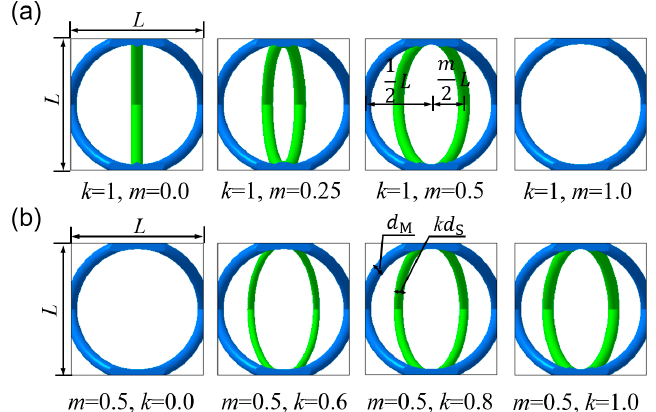
Figure 2. Effect of parameters 𝑘 and 𝑚 on the unit cell configuration of the hierarchical circular- cell lattice structure (HCirC): ( a ) k is fixed at 1.0, and m is varied from 0.0 to 1.0; ( b ) m is fixed at 0.5, and k is varied from 0.0 to 1.0.